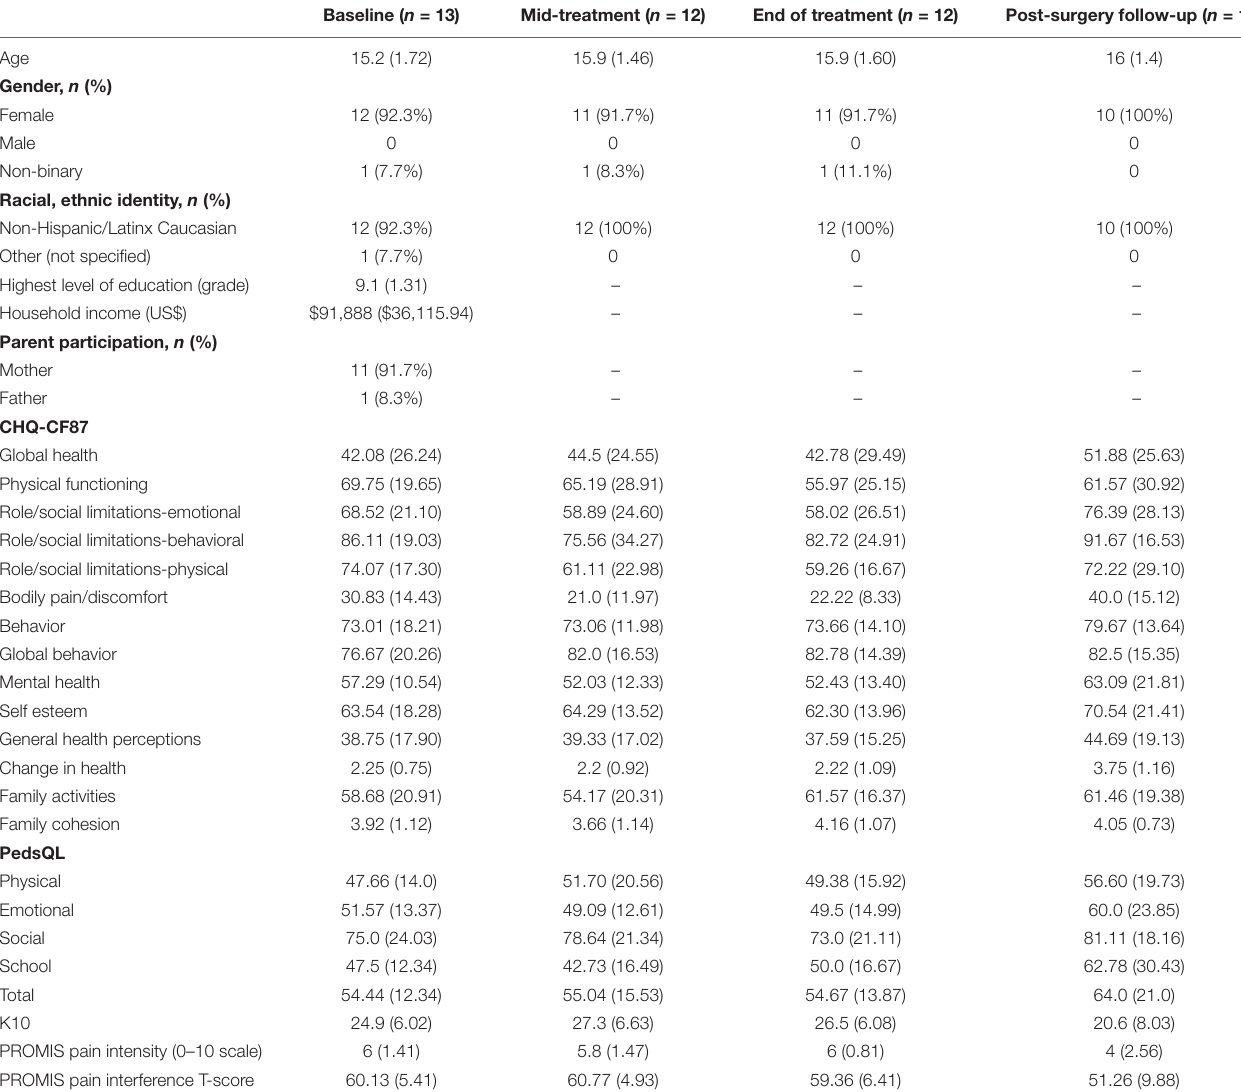
TABLE 2 | Sample characteristics, M